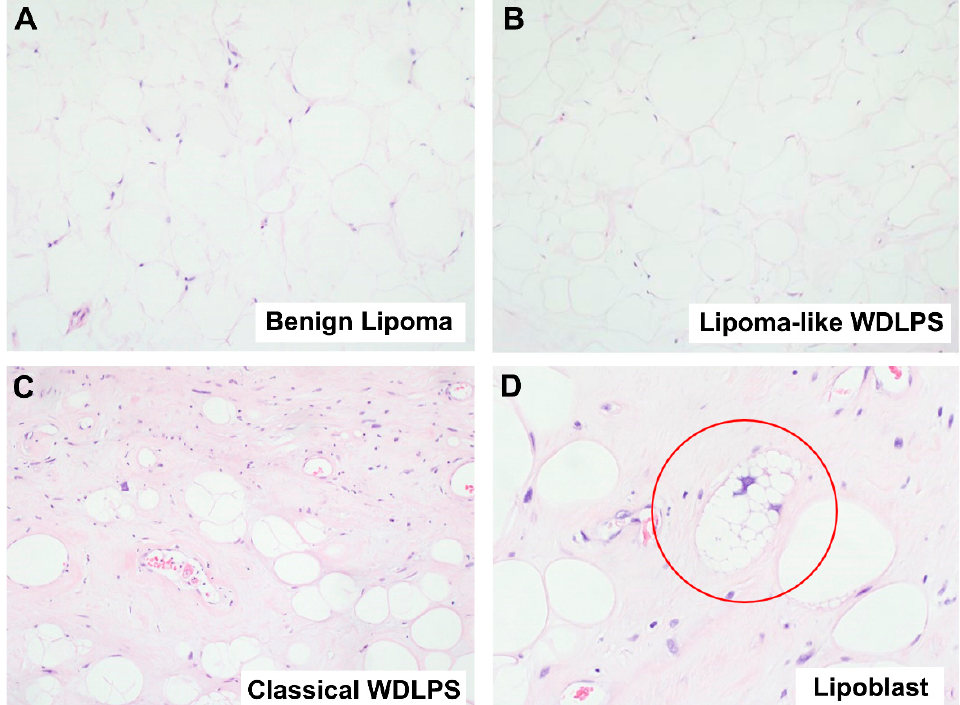
Figure 1. Histological comparison between benign lipoma and malignant well-differentiated lipo- sarcoma (WDLPS). ( A ) Microscopic image of a benign lipoma, showing lobules of mature adipo- cytes with minimal variation in adipocytic size and no nuclear atypia (Hematoxylin and Eosin (H&E) stain, 100× magnification). ( B ) Microscopic image showing lipoma-like WDLPS (H&E stain, 100× magnification). A lipoma-like WDLPS can show marked morphologic similarity to lipoma (Fig- ure 1A), making it hard to differentiate between the two based on morphology alone. ( C ) Micro- scopic image of a malignant WDLPS, showing adipocytes with significant variation in size and shape as well as enlarged, hyperchromatic nuclei (H&E stain, 100× magnification). ( D ) Microscopic image of a lipoblast (circled in red) from a case of malignant WDLPS (H&E stain, 200× magnifica- tion). A lipoblast is characterized by multiple clear cytoplasmic vacuoles that identify a hyperchro- matic nucleus.